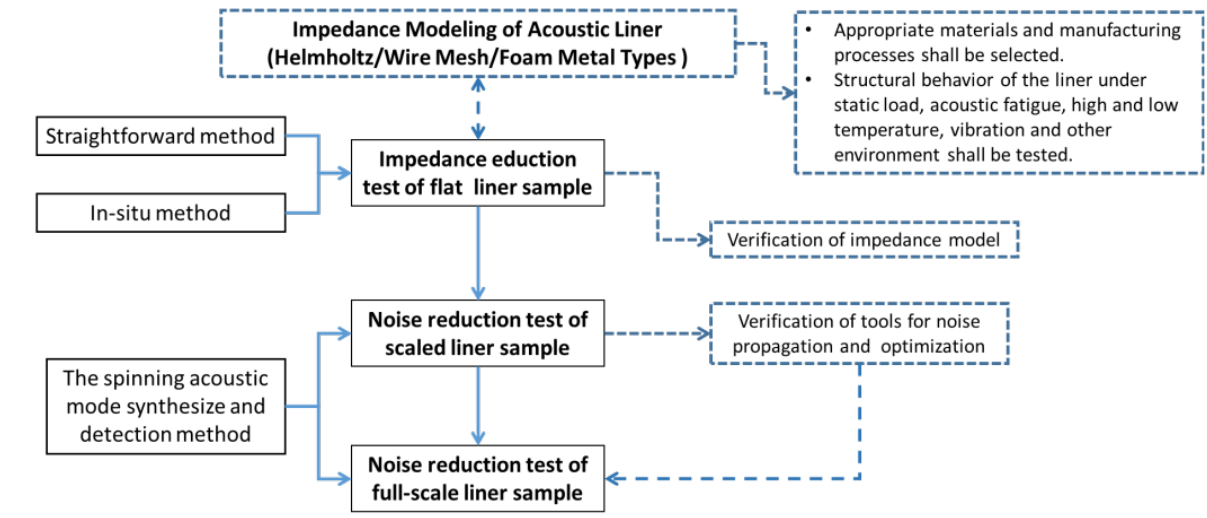
Figure 1. A workflow of activities and outcome in current research.